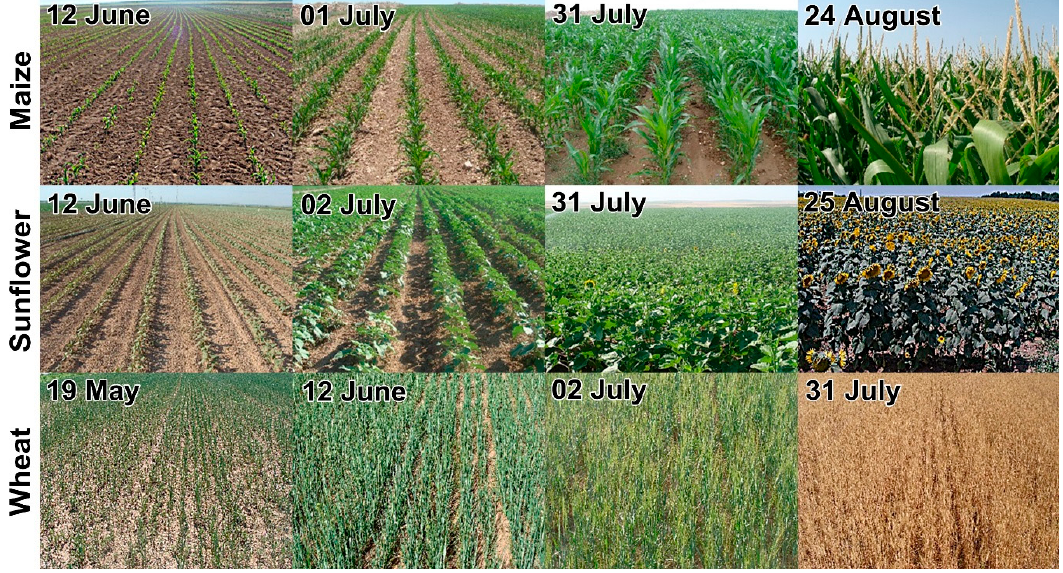
Figure 5. Different growth stages of crops in the study area.